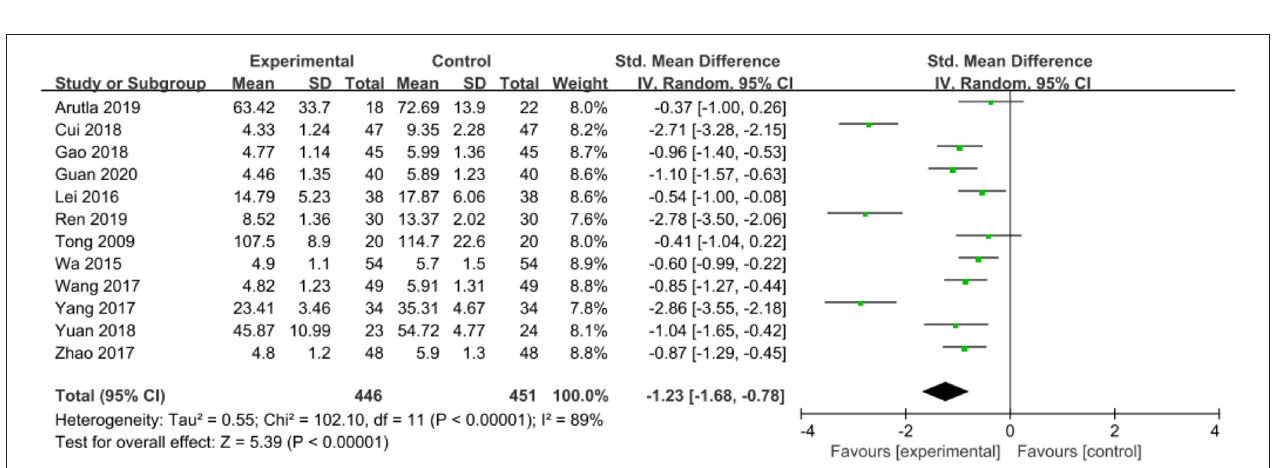
FIGURE 16 | Forest plots of CRP associated with experimental group (parenteral or enteral nutrition group supplemented with Gln) vs. control group (conventional nutrition group). I 2 tests and P are the criteria for the heterogeneity test, (cid:7) , pooled standard mean difference; — (cid:4) —, standard mean difference, and the edges of (cid:7) , 95% CI.